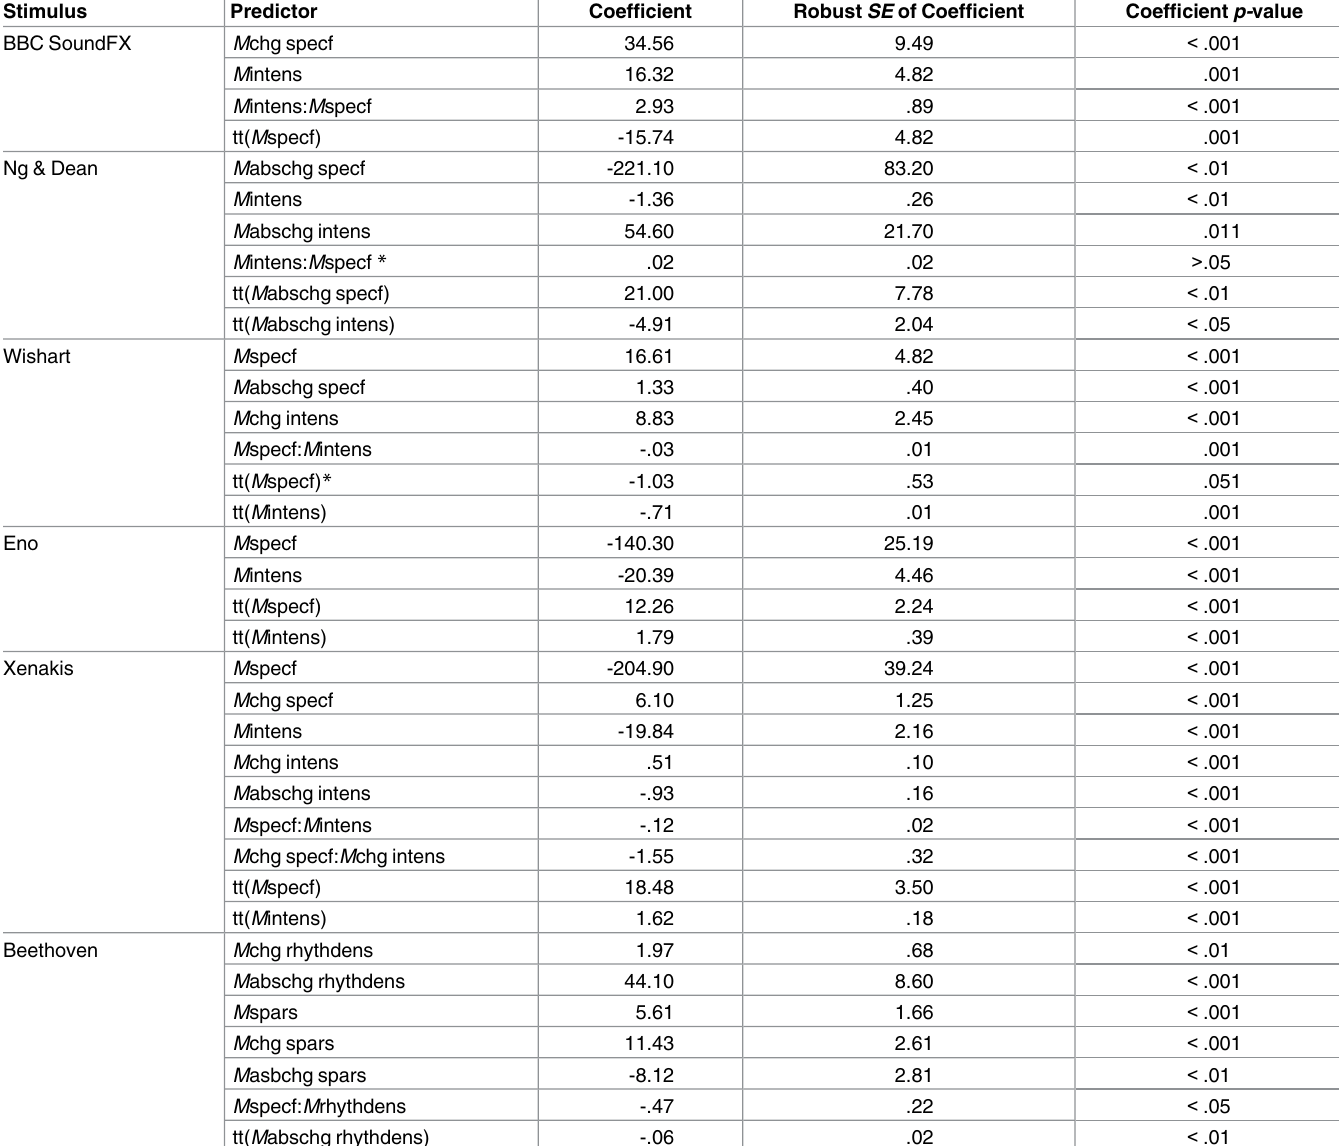
Table 4. Predictors in the selected cox hazard models of perceived phrases using the ‘whole-phrase’ global approach.